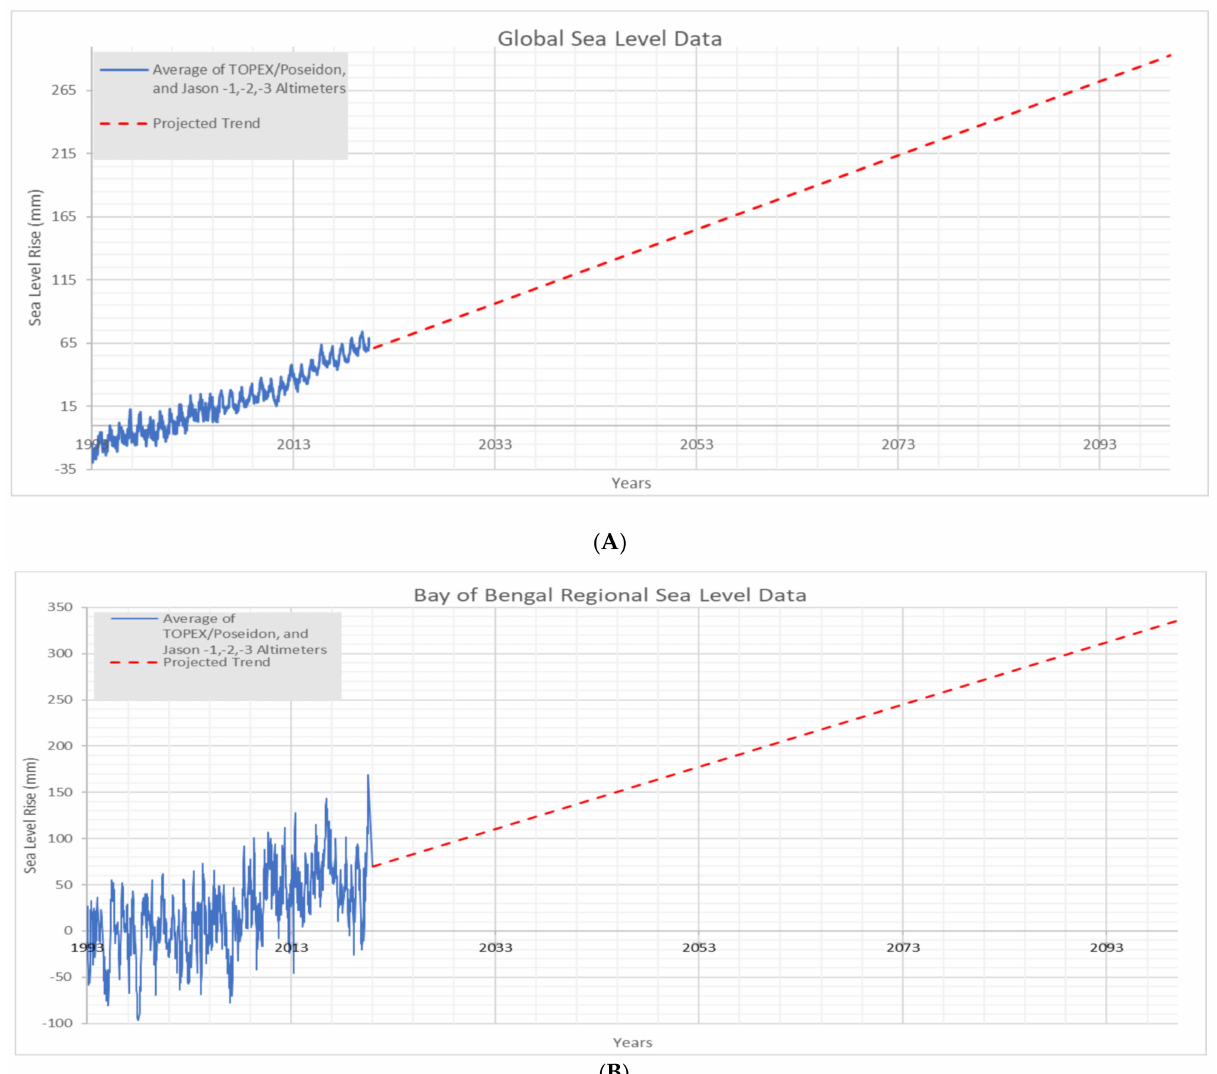
Figure 5. Sea level change for the global average ( A ) and the region of the Bay of Bengal ( B ) from 1993 to 2020, along with the projected trend until 2100, based on the linear trend line equation of the historical record. Data retrieved from the Laboratory for Satellite Altimetry